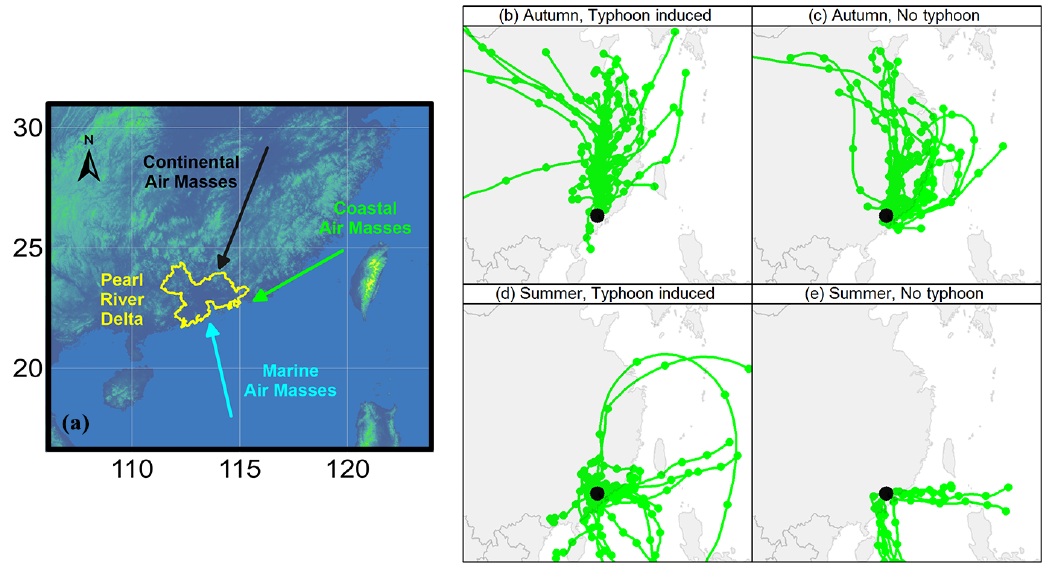
Figure 3. (a) The three O 3 transport paths towards the PRD. (b–e) Backward trajectories at 14:00LT for each scenario, i.e. (b) autumn (typhoon-induced), (c) autumn (no-typhoon), (d) summer (typhoon-induced) and (e) summer (no-typhoon). The black dots indicate the end point of all trajectories, i.e. where the Modiesha site in the central PRD is